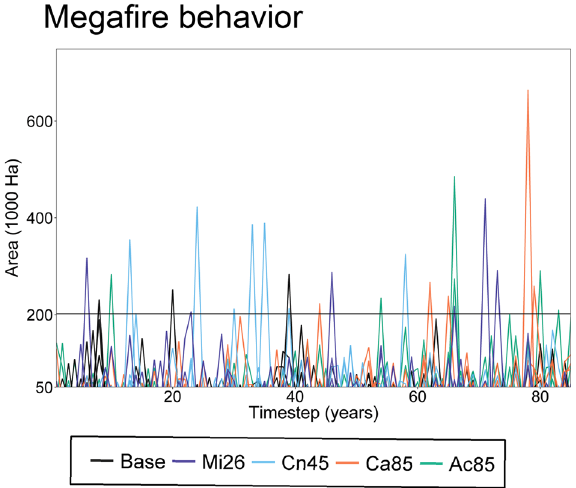
Figure 4. Time series of maximum fire size for different model simulation. Horizontal solid line indicates the historical maximum fire size recorded in the area (Biscuit fire 202,000 ha). See Table 1 for climate change scenario acronyms.